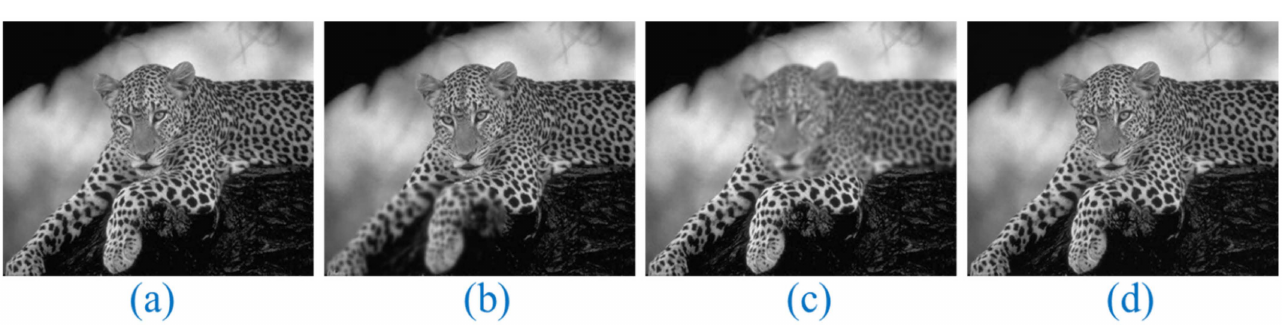
Figure 3. Multi-focus image of a balloon from various perspectives. Original Image: ( a ), Multi-focus Input Images: ( b , c ), and Proposed Fusion: ( d ).